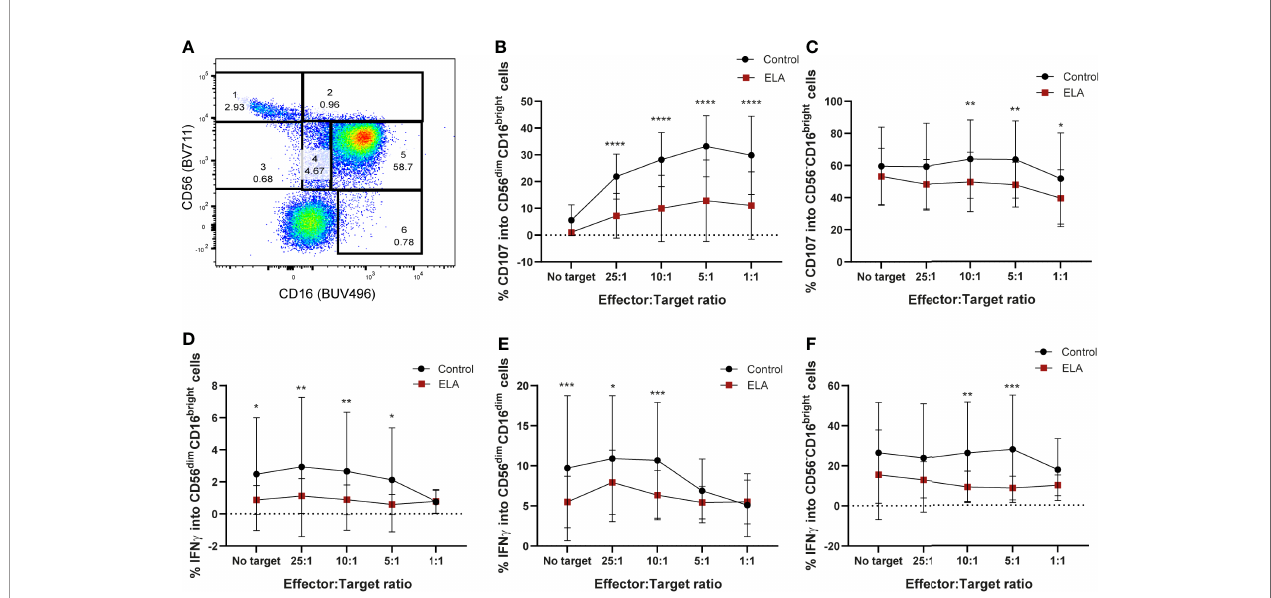
FIGURE 5 | Maternal deprivation changes the degranulation capacity of the NK cells from ELA individuals. Cells were gated as lymphocytes from FSC-H, SSC-H; singlets from SSC-H, SSC-A; then from CD3-CD19- cells. (A) representative image of the NK cell population gating strategy: 1 – CD56 bright CD16 - ; 2 – CD56 bright CD16 + ; 3- CD56 dim CD16 + ; 4 – CD56 dim CD16 dim ; 5- CD56 dim CD16 bright ; 6 – CD56 - CD16 bright ; (B, C) expression of CD107a by populations 5 and 6; (D – F) expression of IFN- g by populations 4, 5 and 6. Data is presented as mean ± SEM of 14 donors per group. Statistics: Two-way ANOVA; *p < 0.05; **p < 0.01; ***p < 0.001; ****p <